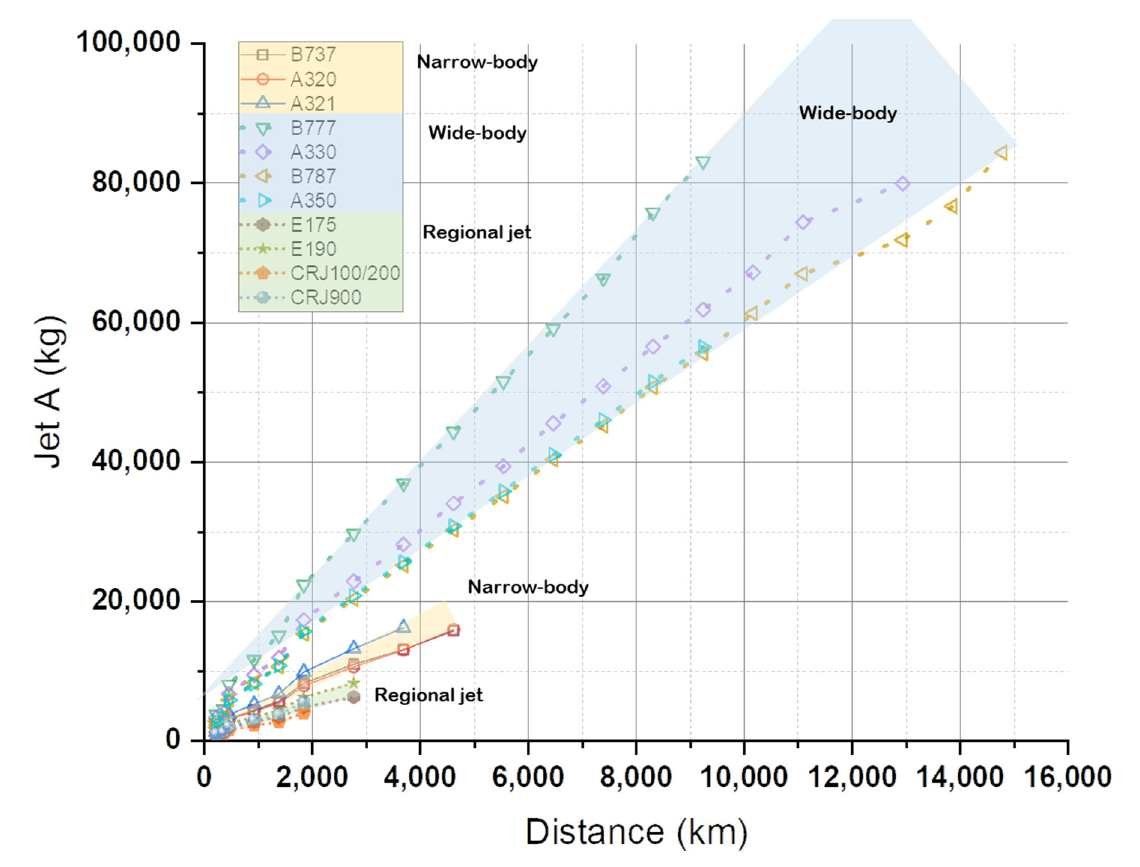
Figure 4. Jet fuel consumption depends on aircraft type and distance [40].